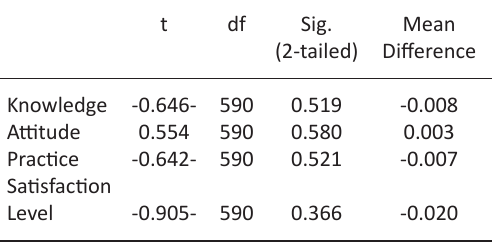
Table 4. Independent Samples Test, regarding the mean difference of Knowledge, Attitude, Practice